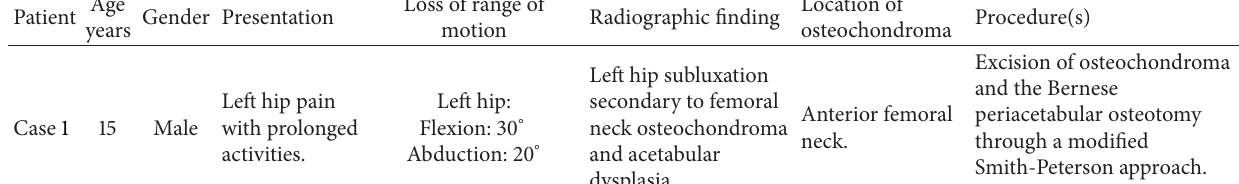
Table 1: Basic demographics and clinical data of three patients included in this